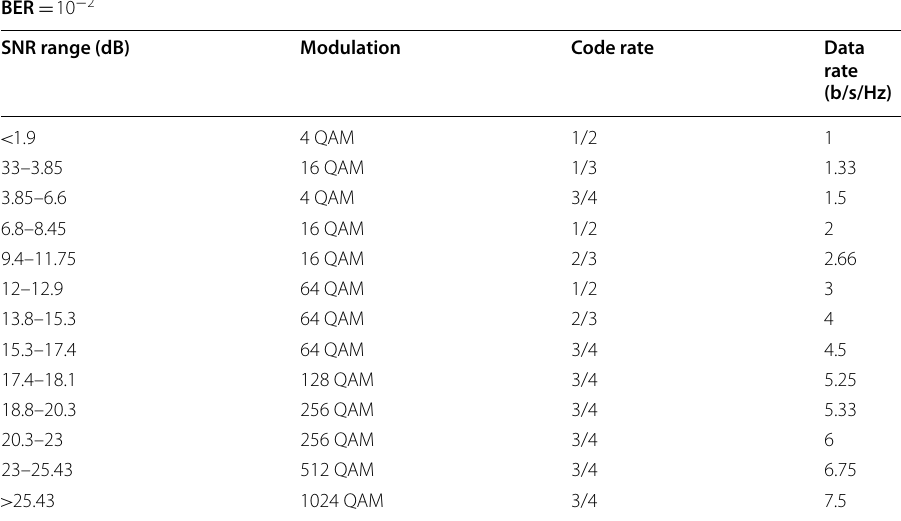
Table 7 Sample of spectrally efficient modulation-code pair which give a target BER of 10 − 2 at given range of SNR value 10 − 2 BER = SNR range (dB)